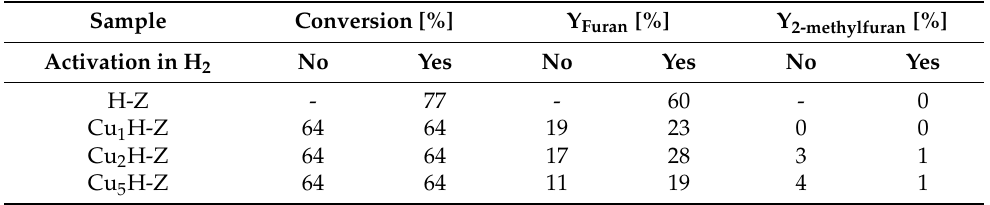
Table 5. The influence of the application of pretreatment in hydrogen at 400 ◦ C on catalytic properties of Cu containing HFAU31-type samples. The presented catalytic results refer to 400 ◦